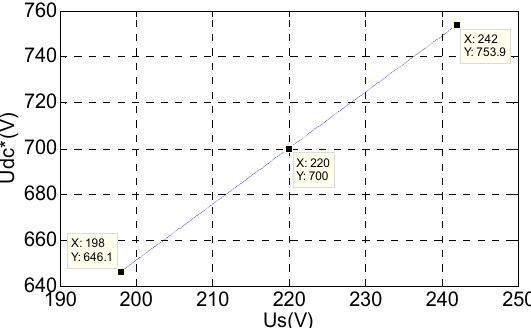
Figure 3. Reference value of DC-link voltage by droop regulator.